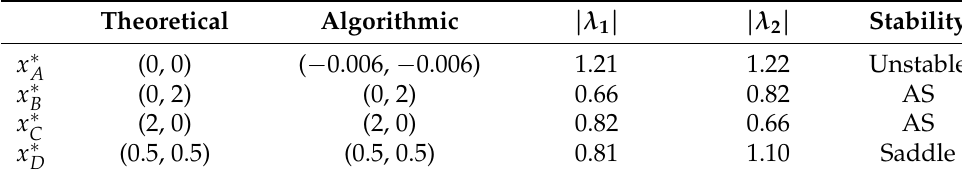
Table 1. Competition model fixed points, location, and stability.